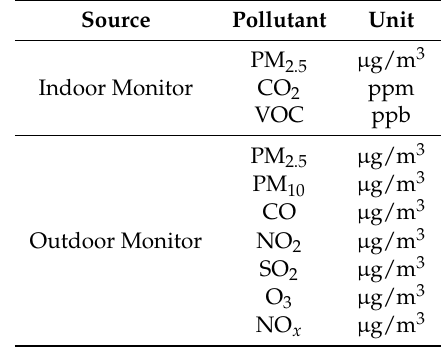
Table 1. Available Pollutants for each Data